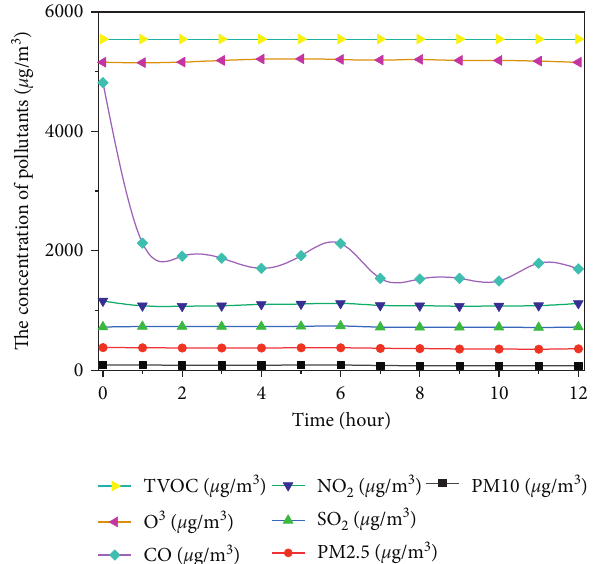
Figure 5: The amount of pollution before construction.